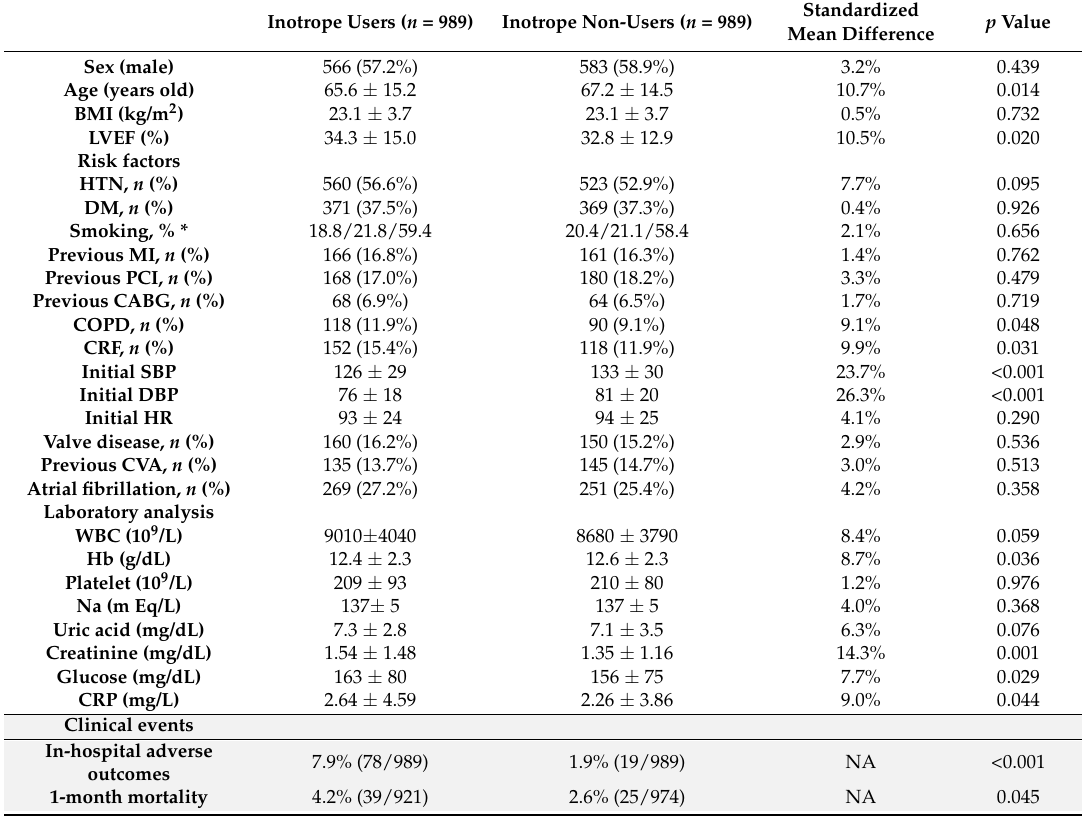
Table 6. Characteristics and outcomes after propensity score